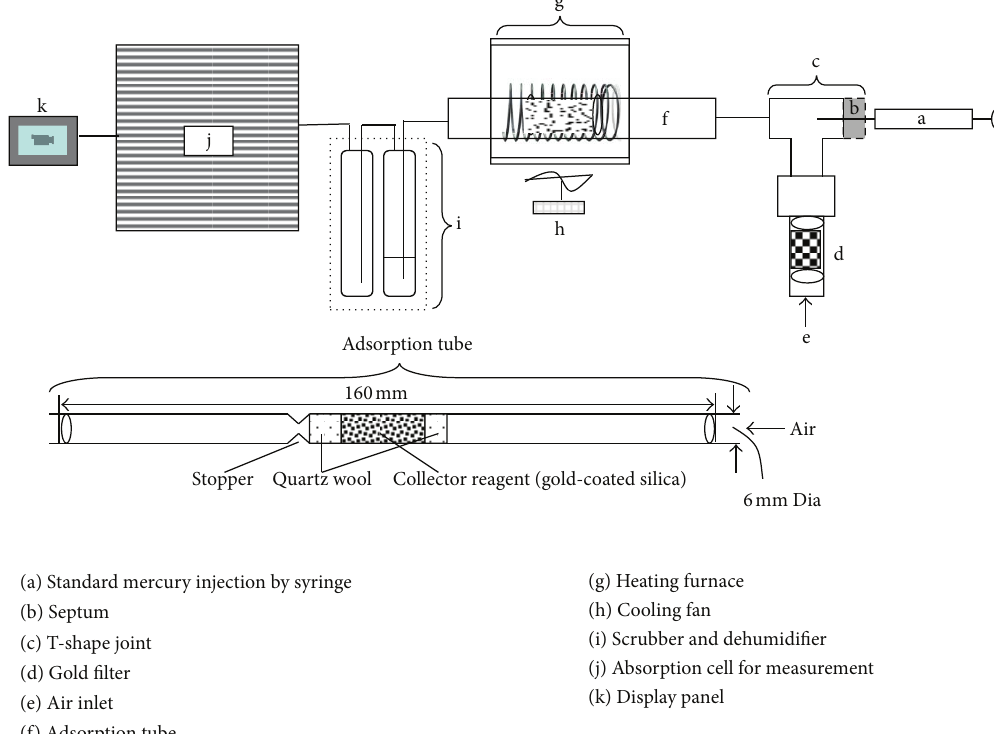
and 50 ng) of standard mercury were taken from the gas